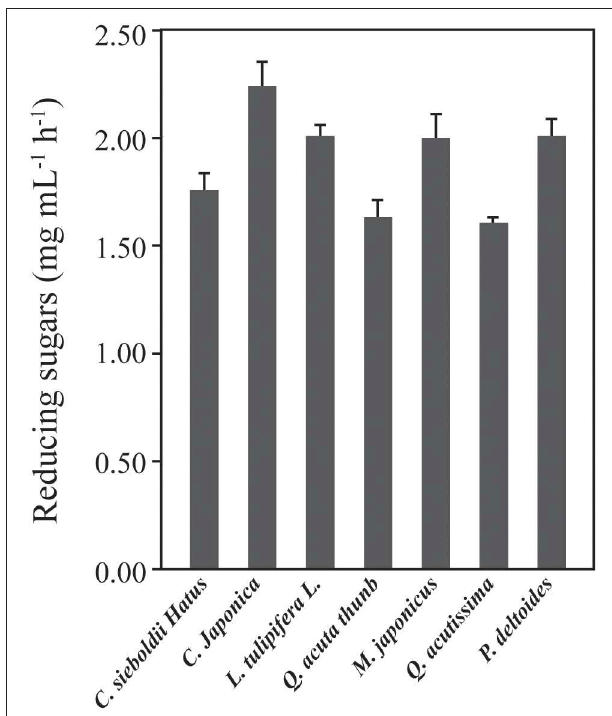
FIGURE 4 | Comparison of the initial rates of various hardwoods in enzymatic hydrolysis. The hardwoods were pretreated with the HPAC solution at 80 ◦ C for 2h and hydrolyzed with 7.5 FPU cellulase g − 1 biomass at 50 ◦ C for 3h. The hydrolysis rate of Q. acutissima showed the significant difference to the rate